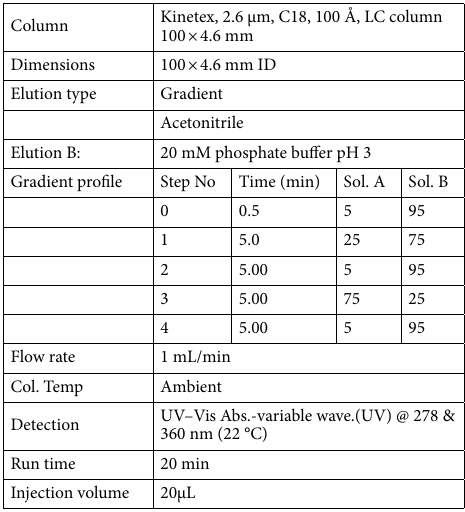
Table 1. HPLC Conditioned for Folic Acid and Vitamin B 12